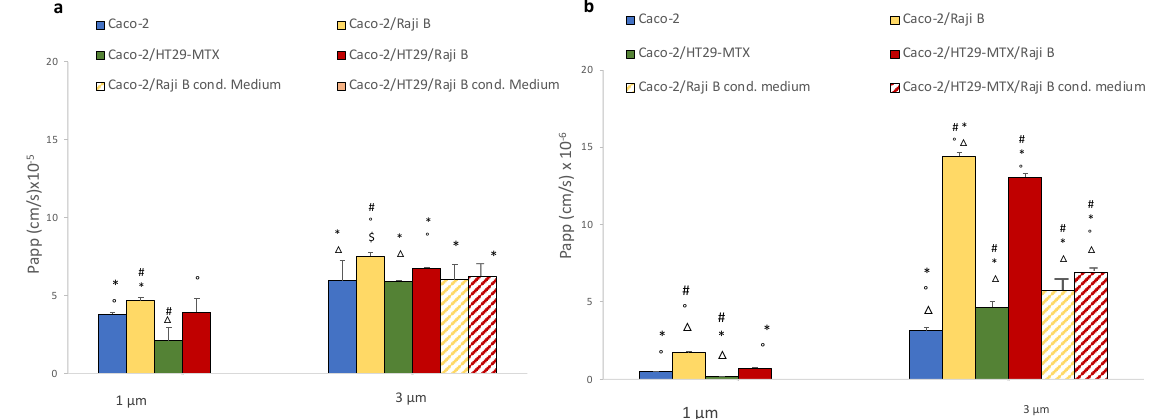
Figure 7. FITC-dextran ( a ) and LY translocation ( b ) in 1 and 3 µ m pore size inserts at 21st day of culture. Results are the medium of three separate experiments performed in triplicate. Statistical analysis was performed by One-way Anova Test followed by post hoc test (Tukey’s ( p < 0.05) to evaluate group comparison. # versus Caco-2, * versus Caco-2/RajB; ◦ versus Caco-2/HT29-MTX; ∆ versus Caco-2/HT29-MTX/ Raji B, $ versus Caco-2/Raji B medium; δ versus Caco-2/HT29-MTX/ Raji B